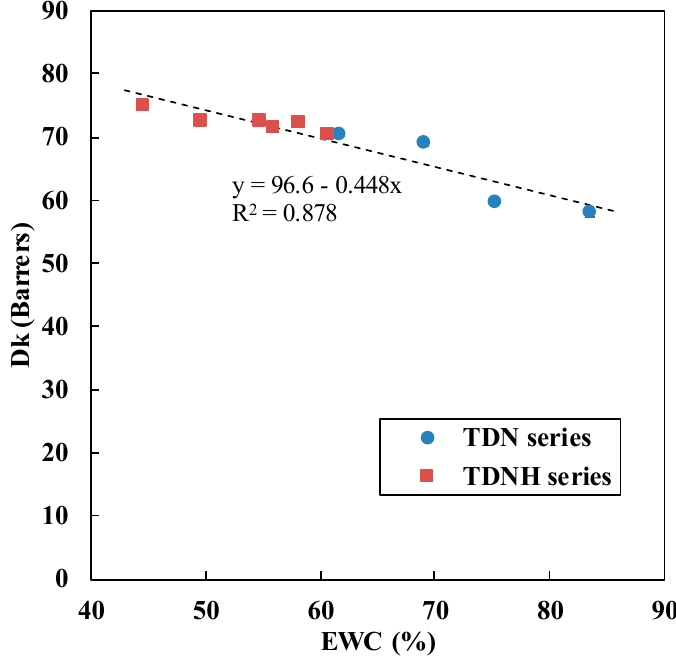
Figure 1. The correlation between Dk and EWC.